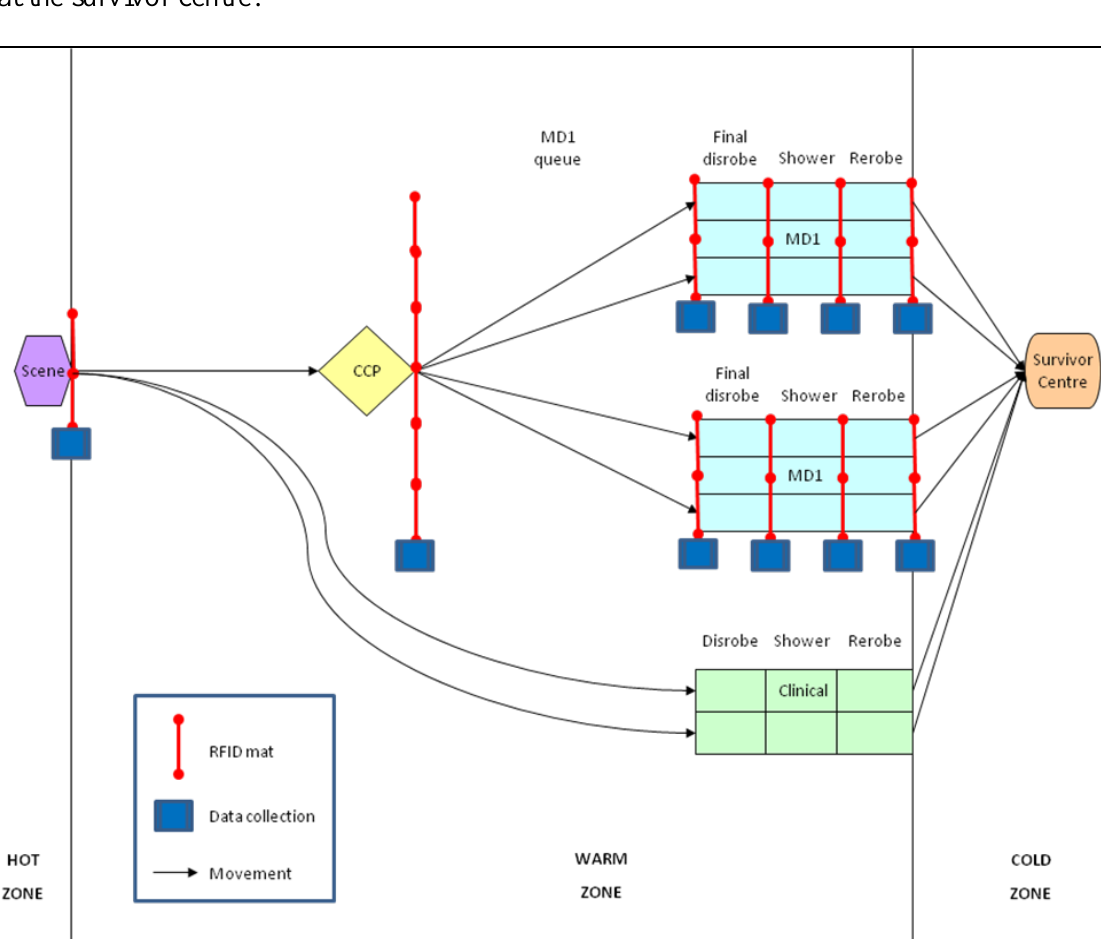
Figure A6. For the purposes of this analysis the warm zone extended to the exits of the three decontamination units (2 × MD1, 1 × Clinical). The initial disrobe was actually performed on the line of 6 radio frequency identification (RFID) detection mats at the edge of the casualty collection point (CCP).The outer lanes of the MD1 were used to process (fe)male ambulant casualties whereas the middle lane was for non-ambulant casualties if required but only when specifically configured and not simultaneously with mass decontamination. Human evaluators captured the disrobe, shower and re-robe timings within the clinical decontamination unit. The exits from the three decontamination units were considered the exits from the system although casualty clearing notionally took place at the survivor